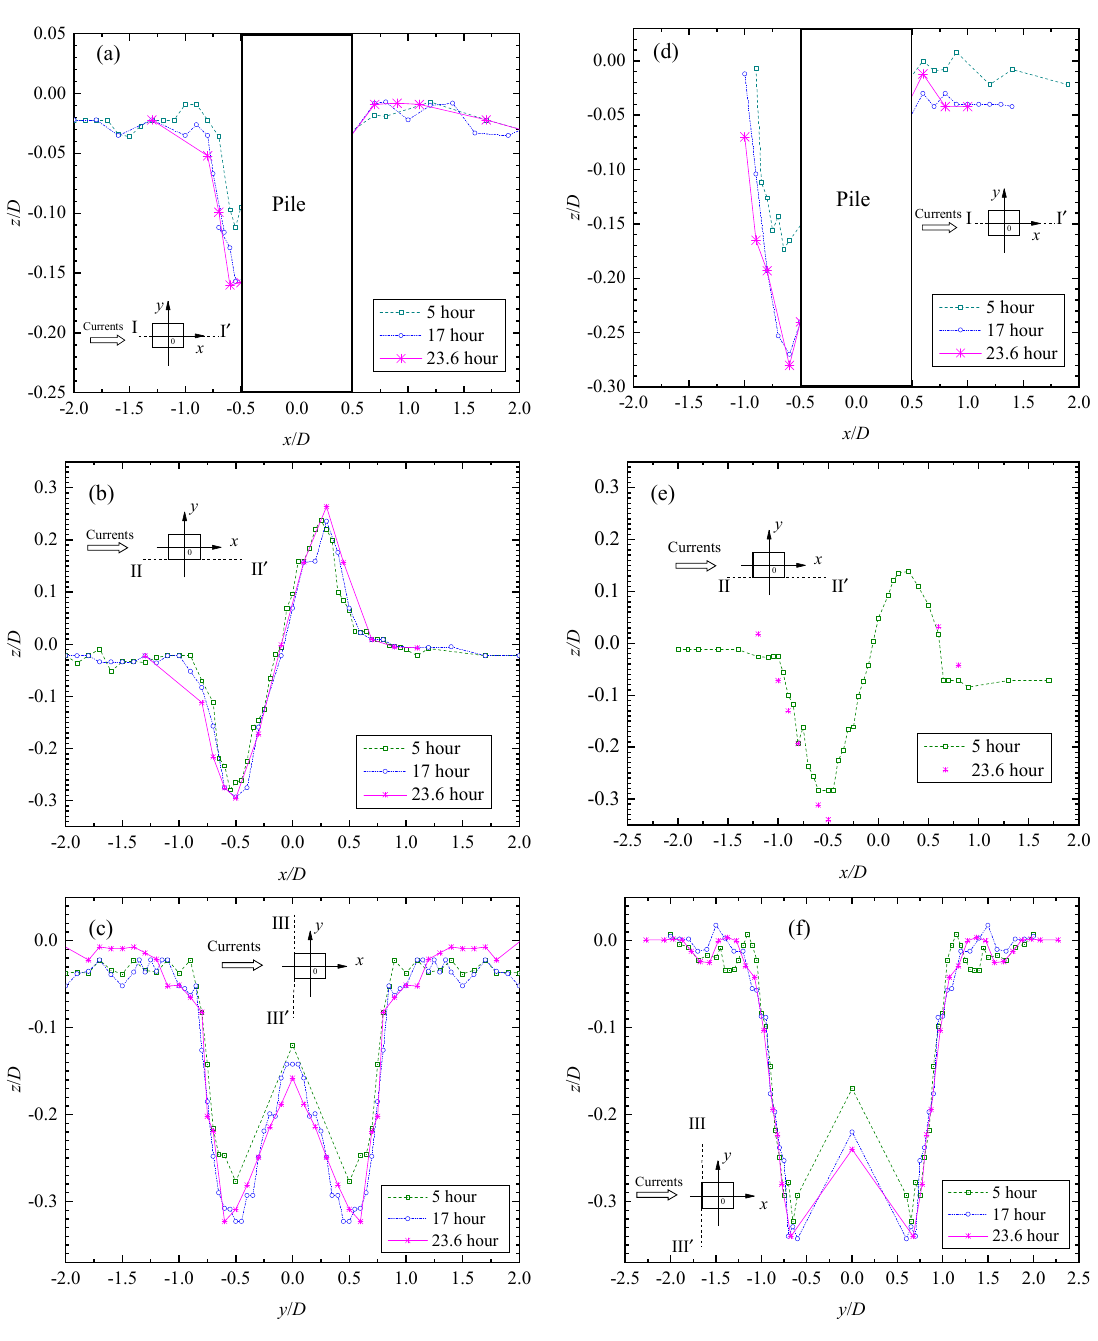
Figure 7. Evolutions of bed profiles. ( a – c ) are sections of test 1; ( d – f ) are sections of test